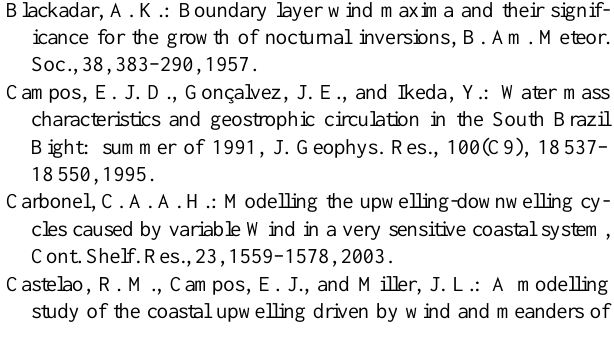
Fig. 8. Same as in Fig. 3, but for 9 August